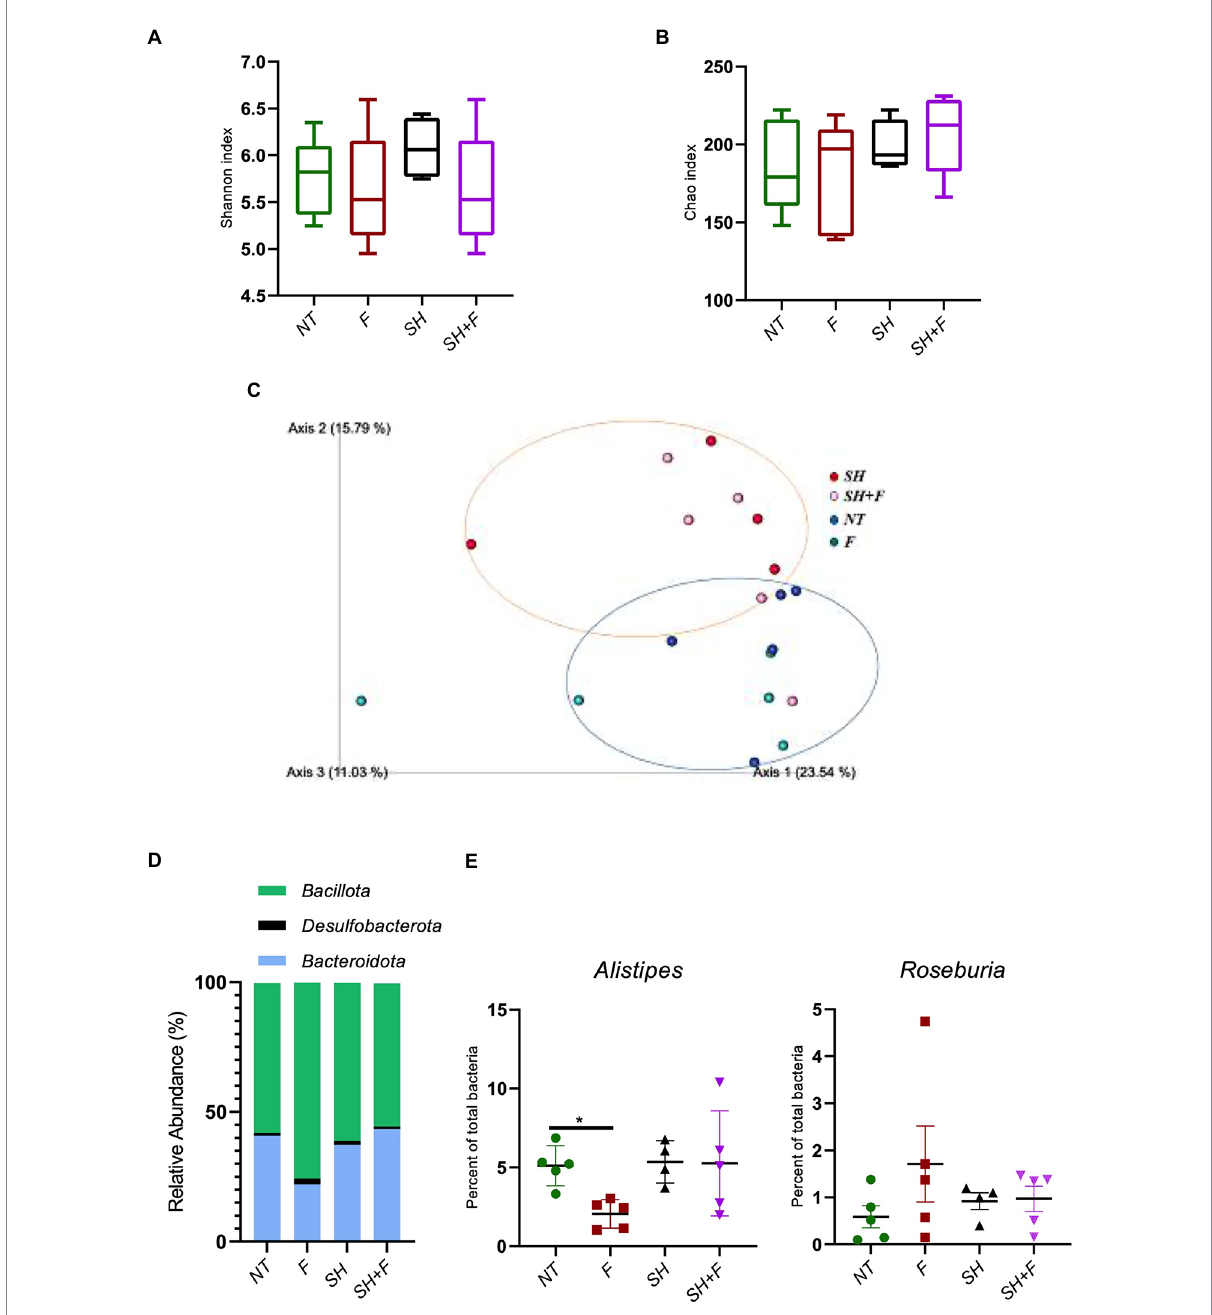
FIGURE 6 Bioactive fractions decreased the genus Alistipes without modifying gut microbiota diversities. Studies on the mice microbiota (16S analysis) were performed on fecal samples. Alpha and Beta diversity studies were completed using a script compatible with the Qiime 2 visualization software. Alpha diversity was represented by the Shannon index (A) and the Chao index (B) . (C) Inter-individual Beta diversity was represented by Qiime 2 visualization based on beta diversity distance (Bray–Curtis dissimilarity). The blue circle represented the Beta diversity cluster of the mice groups not infected with S . Heidelberg. The orange circle represented the Beta diversity cluster of the groups of mice infected with S . Heidelberg. (D) Relative abundance of bacteria phyla was represented excepted phyla with a relative abundance of <0.5%. (E) Quantification of Alistipes and Roseburia genera in each mice